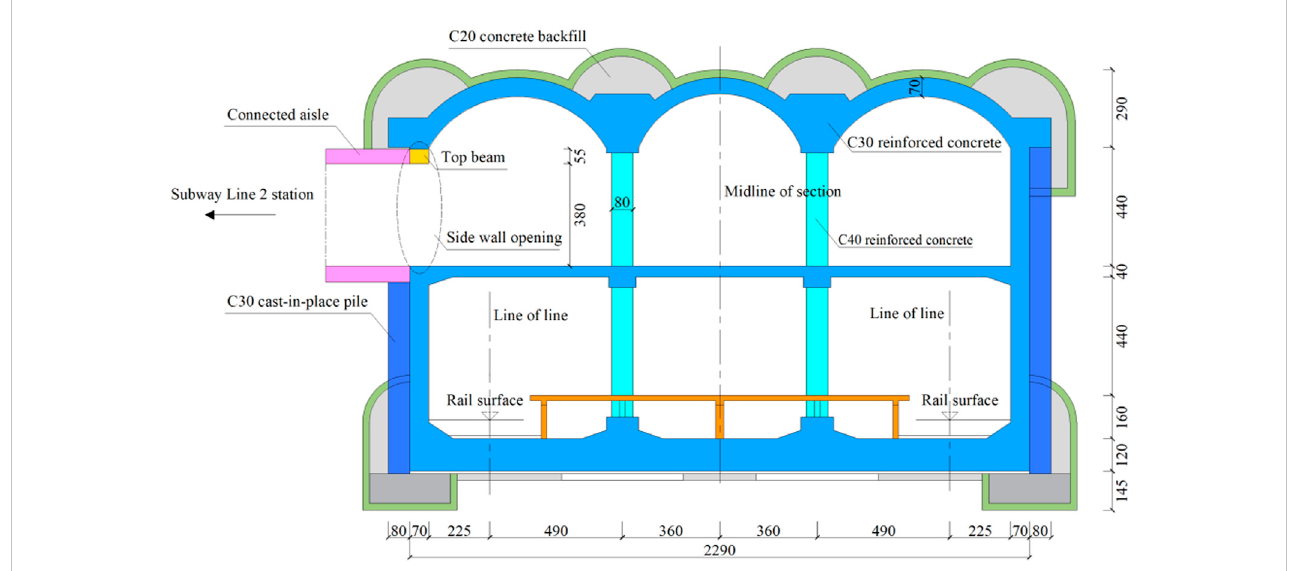
FIGURE 1 Elevation of side wall opening in Xuanwumen Station (cm).